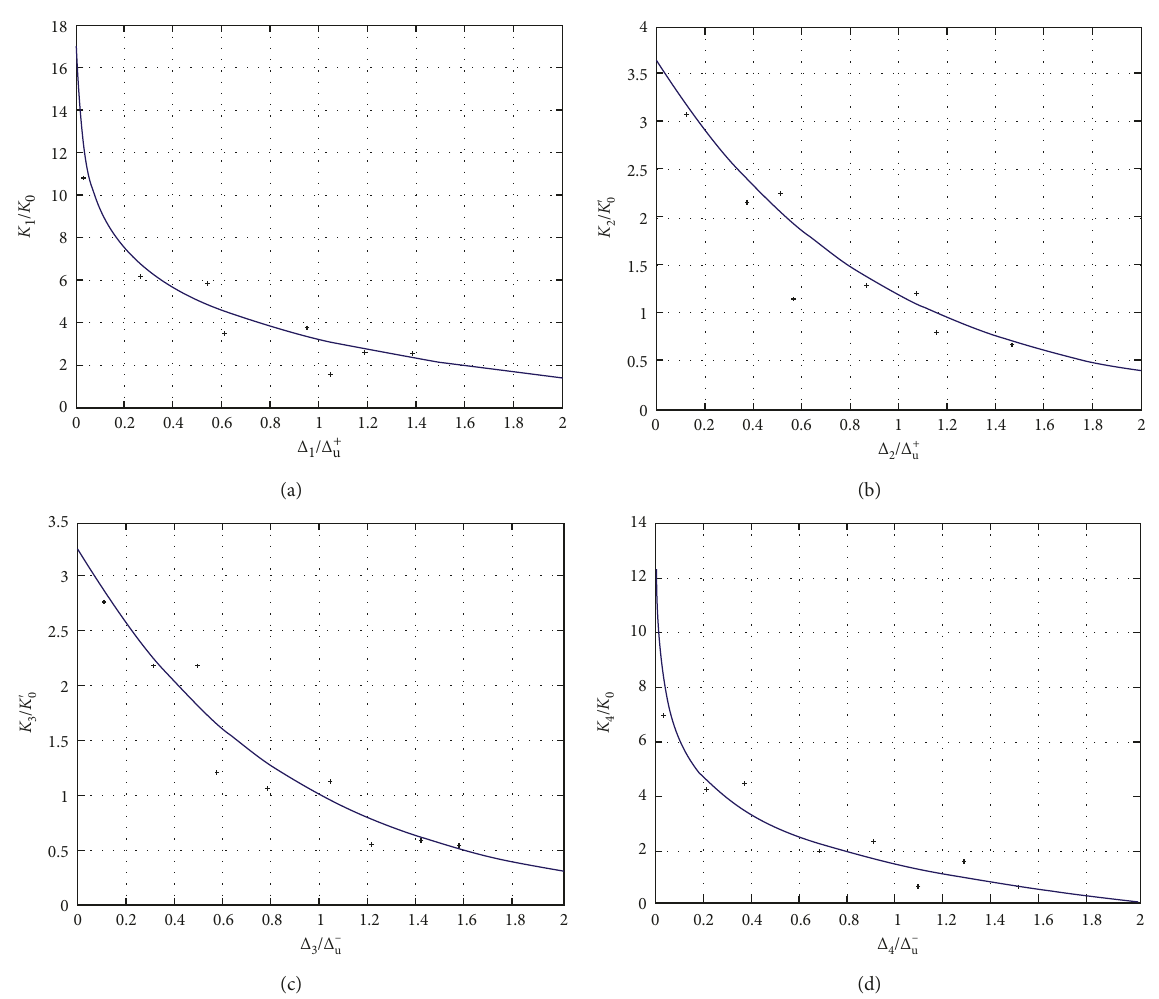
Figure 11: The stiffness deterioration of BCC under the cyclic loading protocol. (a) Positive unloading stiffness. (b) Negative loading stiffness. (c) Negative unloading stiffness. (d) Positive loading